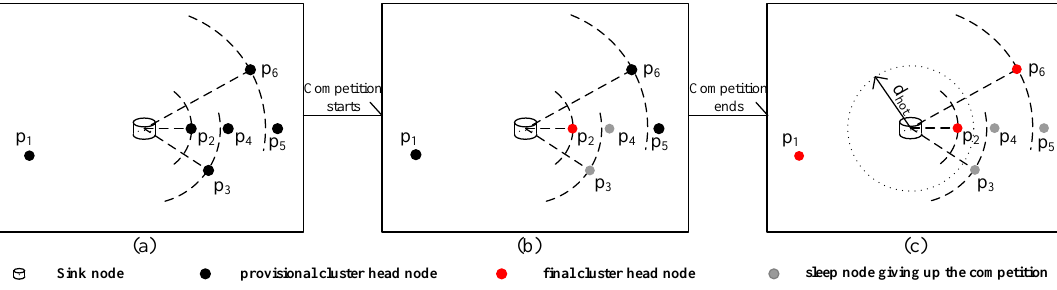
Figure 6. Several stage statuses of uneven clustering. ( a ) Initialization phase of cluster head node competition; ( b ) Phase of cluster head node competition; ( c ) End of cluster head node competition. (Assume that p 2 , p 3 and p 4 can communicate with each other within R 0 and that they are the competition neighbor nodes for each other; so do p 4 , p 5 and p 6 . In addition, p 2 is the next-hop node of p 6 , and the distance between p 1 and the sink node is greater than R c _Max ).